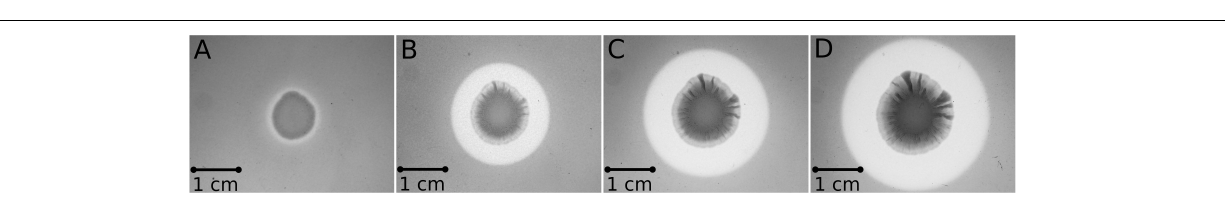
FIGURE 5 | Three-dimensional protein structure comparison and molecular docking. (A) IsPETase three-dimensional structure (PDB ID: 5XJH), the catalytic triad (Ser160, Asp206, His237) is circled in red; the two disulphide bonds (DB1 and DB2) are indicated with arrows. (B) Predicted three-dimensional structure of the SM14est protein, generated using SWISS-MODEL, with the crystal structure of cutinase 1 from Thermobifida cellulosilytica as template (PDB ID: 5LUI). The catalytic triad (Ser156, Asp202, His234) is circled in red. (C) Molecular docking simulation performed using AutoDock Vina, with BHET as substrate, indicated with an arrow, detailing the binding pocket, which is circled in red. The catalytic triad residues are shown as sticks. Structures were analyzed and rendered using the UCSF Chimera software.